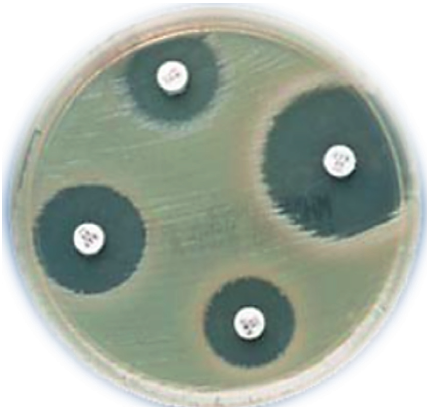
Figure 1: Aura of microbial nothing in the diffusion method from the